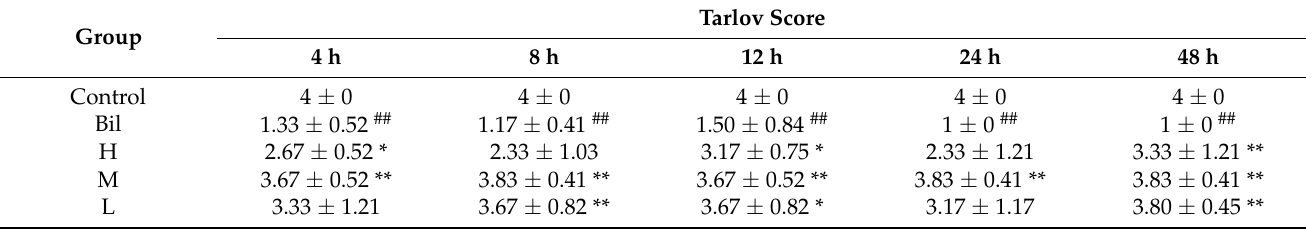
Table 1. Tarlov scores of mice in each group at 4 h, 8 h, 12 h, 24 h and 48 h after modeling (Mean ±